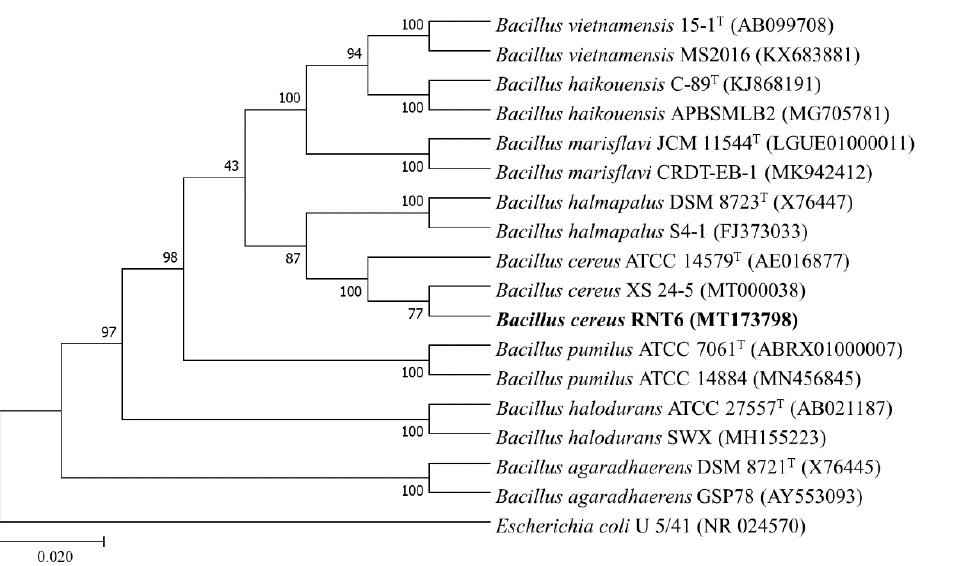
Figure 1. Phylogenetic analysis of B. cereus RNT6 with the type strains and closest Genbank matches of genus Bacillus .